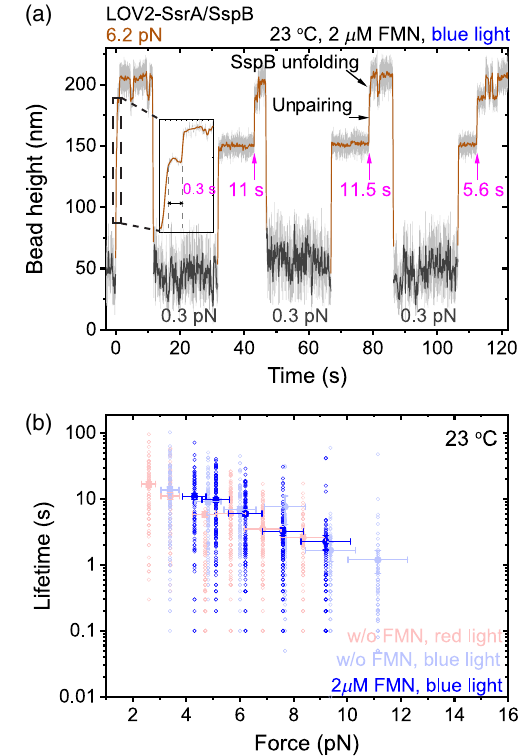
FIG. 6. Mechanical lifetime of the LOV2-SsrA/SspB com- plexes. (a) Representative time trace of bead height change during a force-clamp assay to quantify the lifetime of the LOV2-SsrA/ SspB complex at various forces. After jumping from 0.3 pN to a higher force, the average lifetime of the complex at the higher force is measured in multiple cycles. In this example, the lifetime of the complex at 6.2 pN in four force jumps is shown. The stepwise bead height increase of a step size of approximately 50 nm after the force jump is from unpairing of the LOV2-SsrA/ SspB complex. Following the unpairing, the abrupt extension increase and decrease steps with sizes of approximately 15 nm are from the unfolding and refolding transitions of the SspB domain (indicated by blue arrows). The brown and dark gray lines show a 20-FFT smooth of the raw data (gray). The inset is an enlarge- ment of the unpairing event in the first cycle. (b) Force-dependent lifetimes of LOV2-SsrA/SspB complex in red light (without FMN in solution, light red) and in blue light (without FMN in solution, light blue; with 2 μ M FMN, blue). The solid squares indicate the mean lifetime at a force, while the hollow circles represent individual lifetimes measured. Over 80 lifetimes are measured for each force. The horizontal error bars indicate 10% of relative force calibration uncertainty of the system (see Sec. IV). The vertical error bars indicate standard